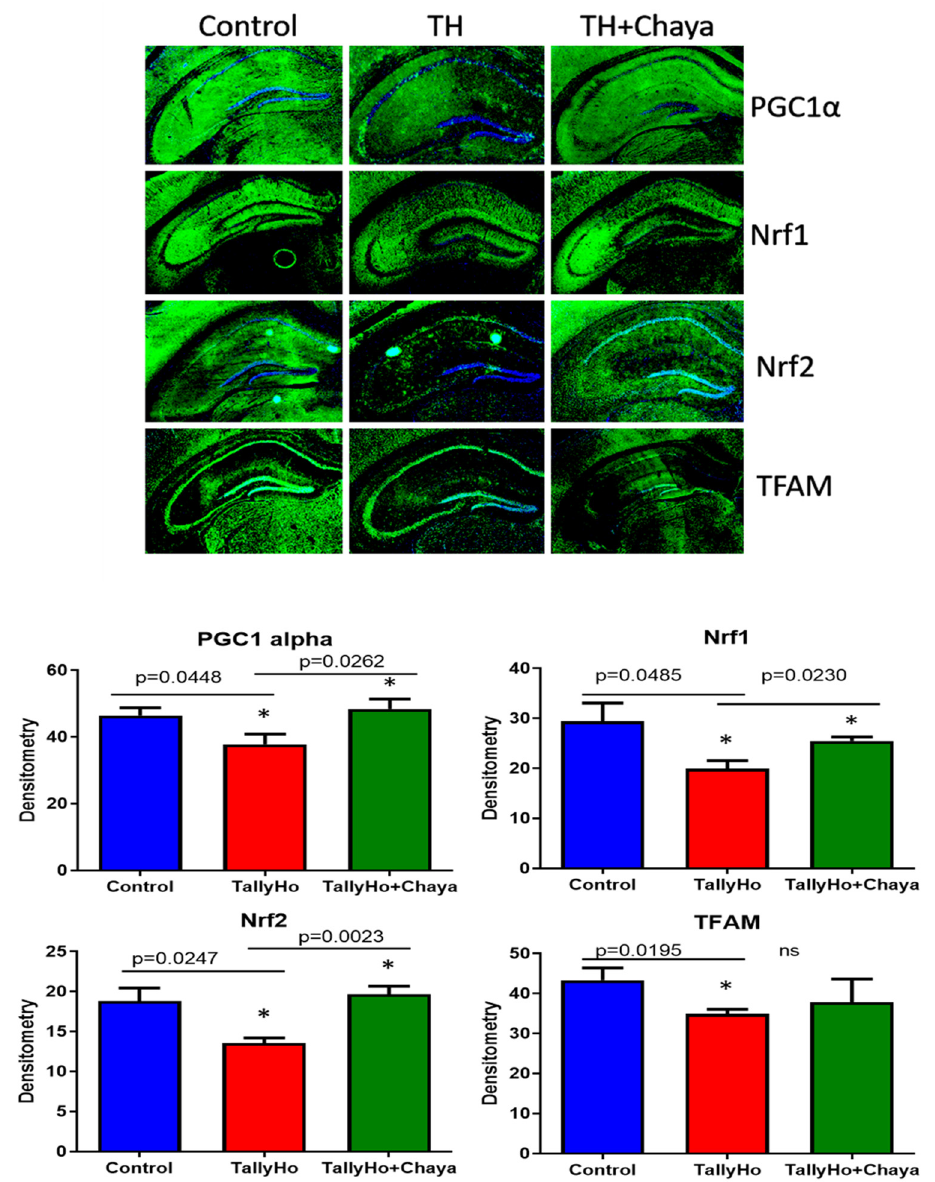
Figure 8. Immunofluorescence analysis of the hippocampal mitochondrial biogenesis proteins of 14-month-old non-diabetic control mice, TH mice fed with chaya, and TH mice fed with regular chow. The TH + chaya mice showed significantly increased levels of PGC1 alpha, Nrf1, and Nrf2, which were reduced in the TH mice (PGC1 alpha, p = 0.0262; Nrf1, p = 0.0230; and Nrf2, p = 0.0023). However, no significant changes were seen in the levels of the TFAM protein in the TH + chaya mice compared to the TH mice. * p =